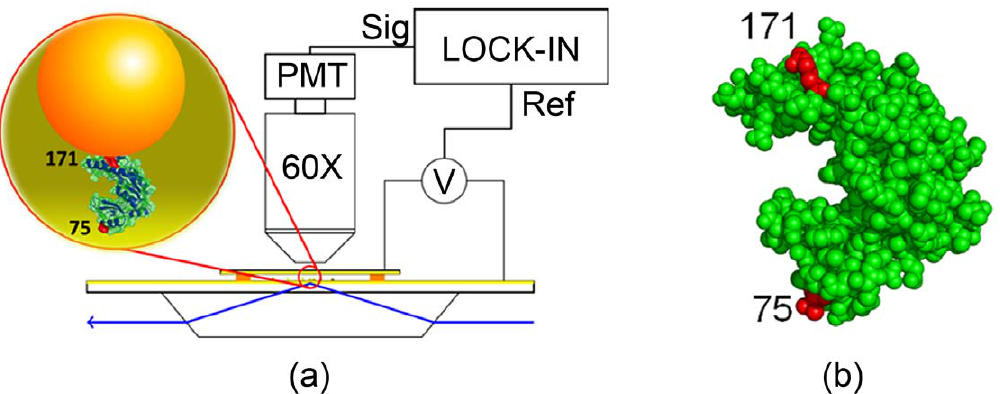
Figure 1. Experimental setup. (a) Schematics of the experimental setup including the chamber, electric excitation, and optical readout. The inset shows the geometry of the protein (Guanylate Kinase, GK) attached by the 171 and 75 sites to a gold nanoparticle (GNP) and a gold film evaporated on the glass slide (not to scale). (b) Crystal structure of GK (PDB: 1S4Q) with the attachment sites 75 and 171 highlighted.